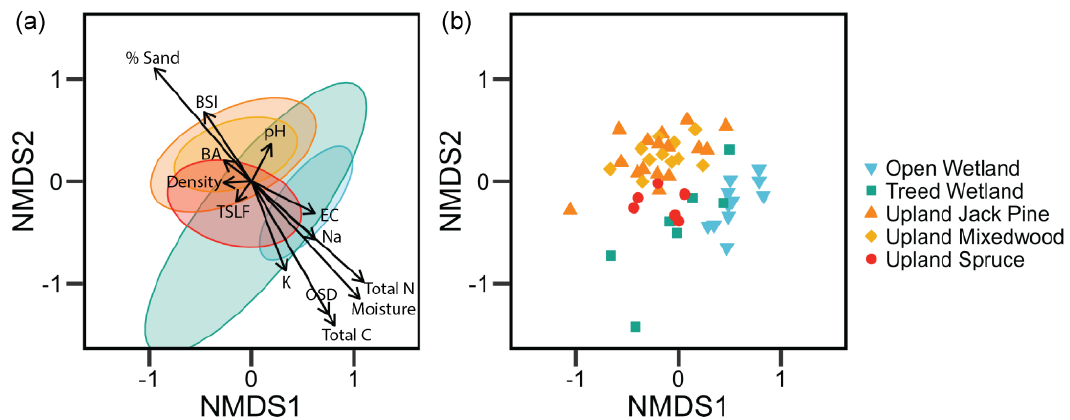
Figure 2. Nonmetric multidimensional scaling (NMDS) of post-fire understory vegetation community dissimilarities. Plot ( a ) shows normal confidence ellipses for topoedaphic vegetation classes (identified by colour) and environmental vectors derived from correlations between environmental variables and the NDMS axes, within the ordination space. Abbreviations of environmental variables are reported in Table 1. The strength of the relationship between an environmental vector and the NMDS ( R 2 ) is indicated by the arrow length. Plot ( b ) shows the individual sites within the ordination space, with topoedaphic vegetation classes identified by point colour and shape. Table 5. Significant (* p ≤ 0.05) indicator species identified using multi-level pattern analysis within six topoedaphic vegetation classes. The indicator species uniquely associated with one group are indicated with a † . Treed Wetland Potentilla palustris (L.) Scop. †